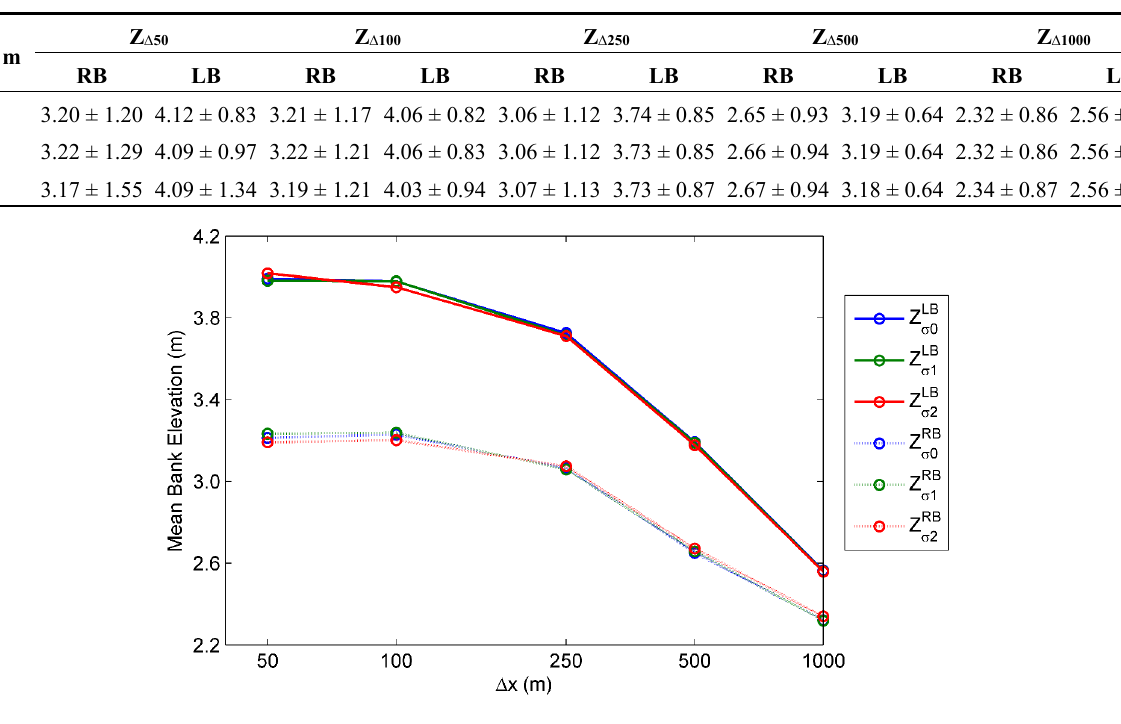
Figure 8. The mean of both left (LB) and right bank (RB) elevations in terms of grid-box size and DEM